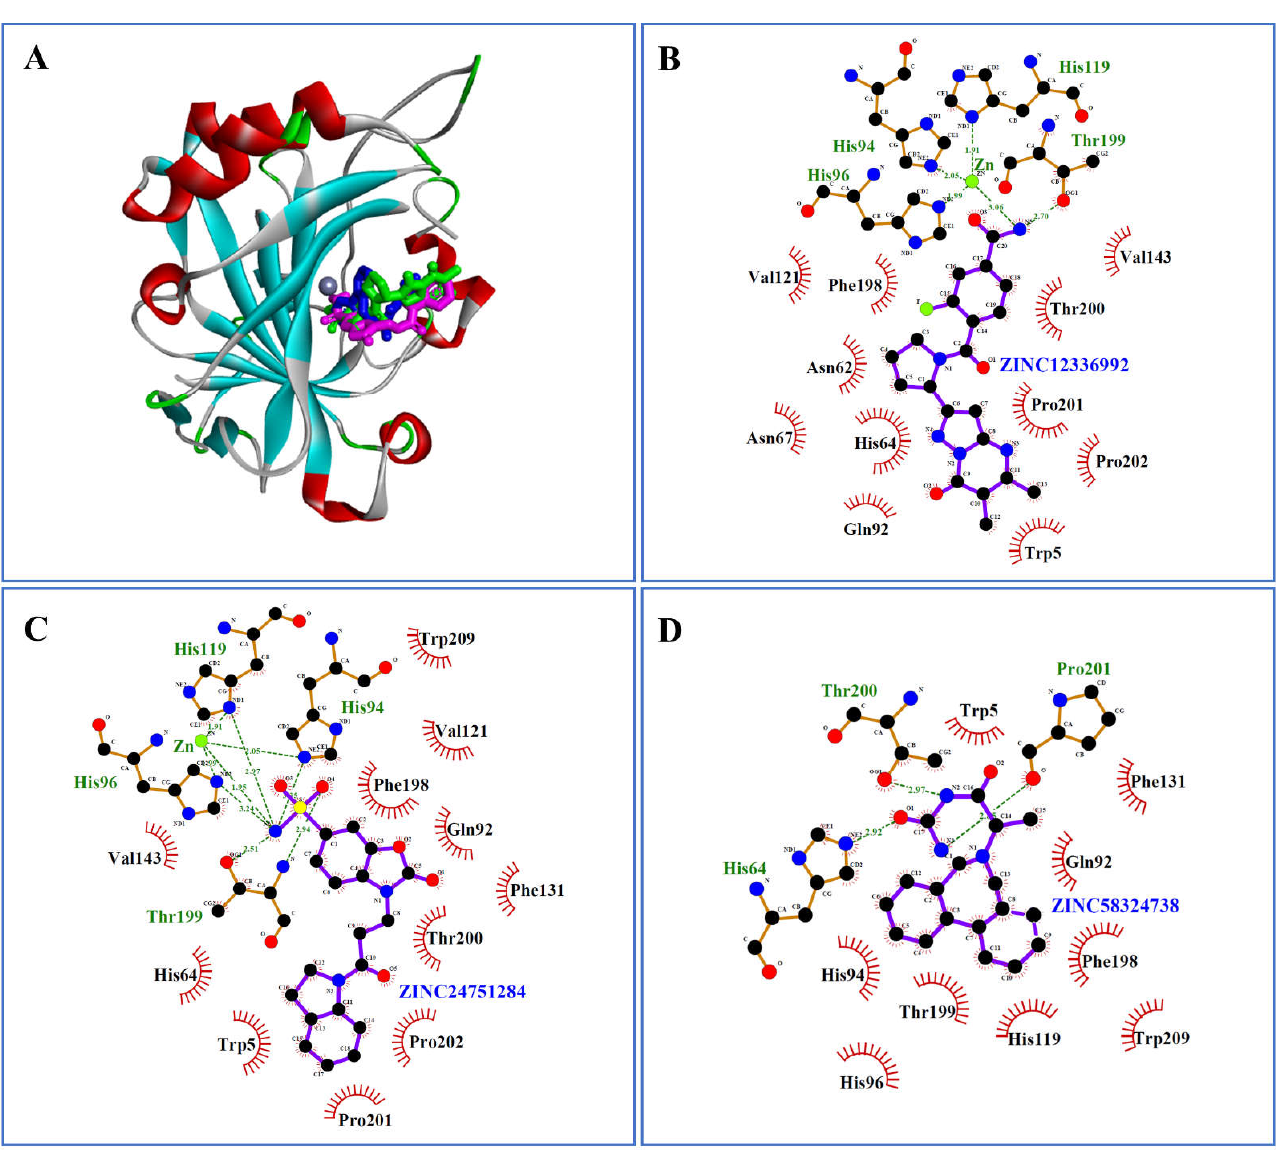
Figure 4. ( A ) Intermolecular complex formed between carbonic anhydrase-II (shown as a ribbon) and ZINC12336992, ZINC24751284, and ZINC58324738, shown as stick styles in green, magenta, and blue, respectively. Zn(II) is represented as a grey ball in the binding pocket. ( B – D ) Ligplot diagrams showing non-bond interactions of the top three hits.